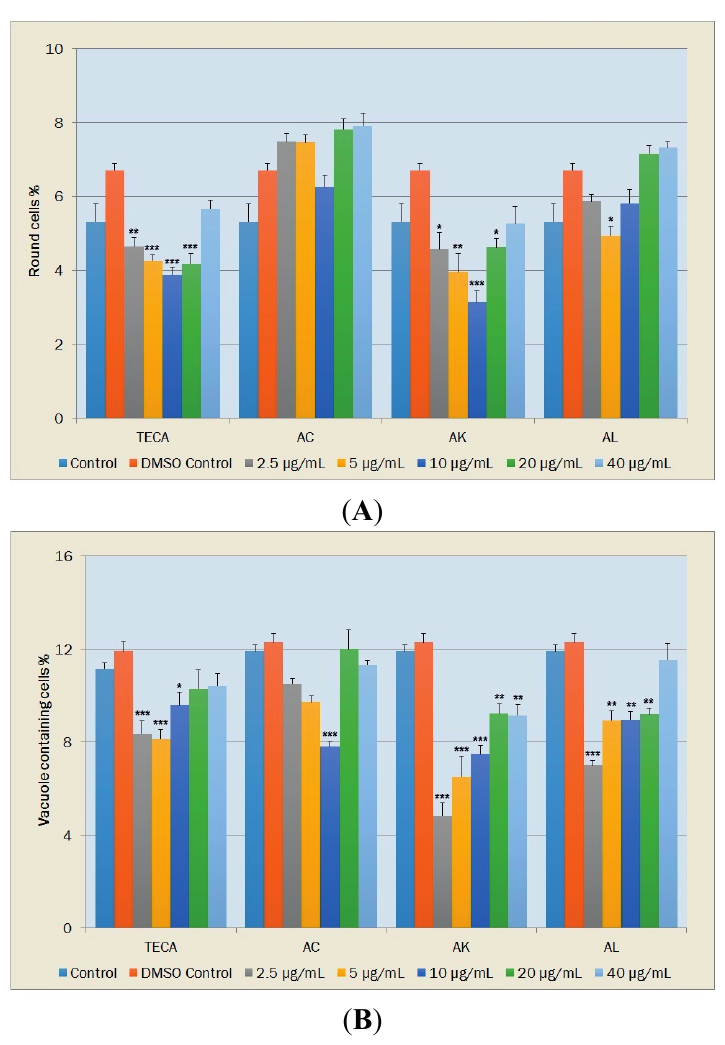
Figure 7. Effects of TECA, AC, AK and AL extracts on percentages of NIH-3T3 fibroblasts in round shape ( A ); and vacuole containing NIH-3T3 fibroblasts ( B ) Data are mean ± SEM values ( n = 5, each case). * p < 0.05, ** p < 0.01, *** p < 0.001, significantly different from control